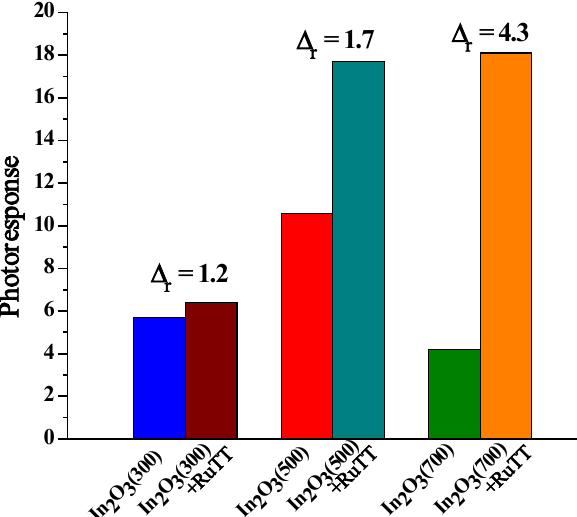
(b) Figure 6. Change in the conductivity of pure In 2 O 3 with different grain sizes ( a ) and hybrid materials ( b ) under dark and irradiation conditions.